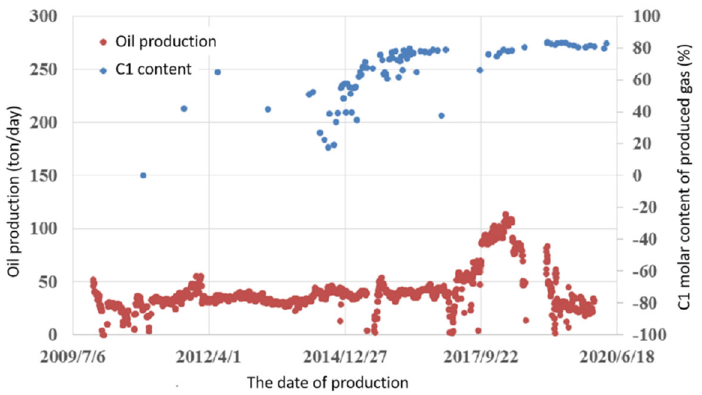
Figure 9. Production curve of oil production and gas C1 content in a gas injection well D11.